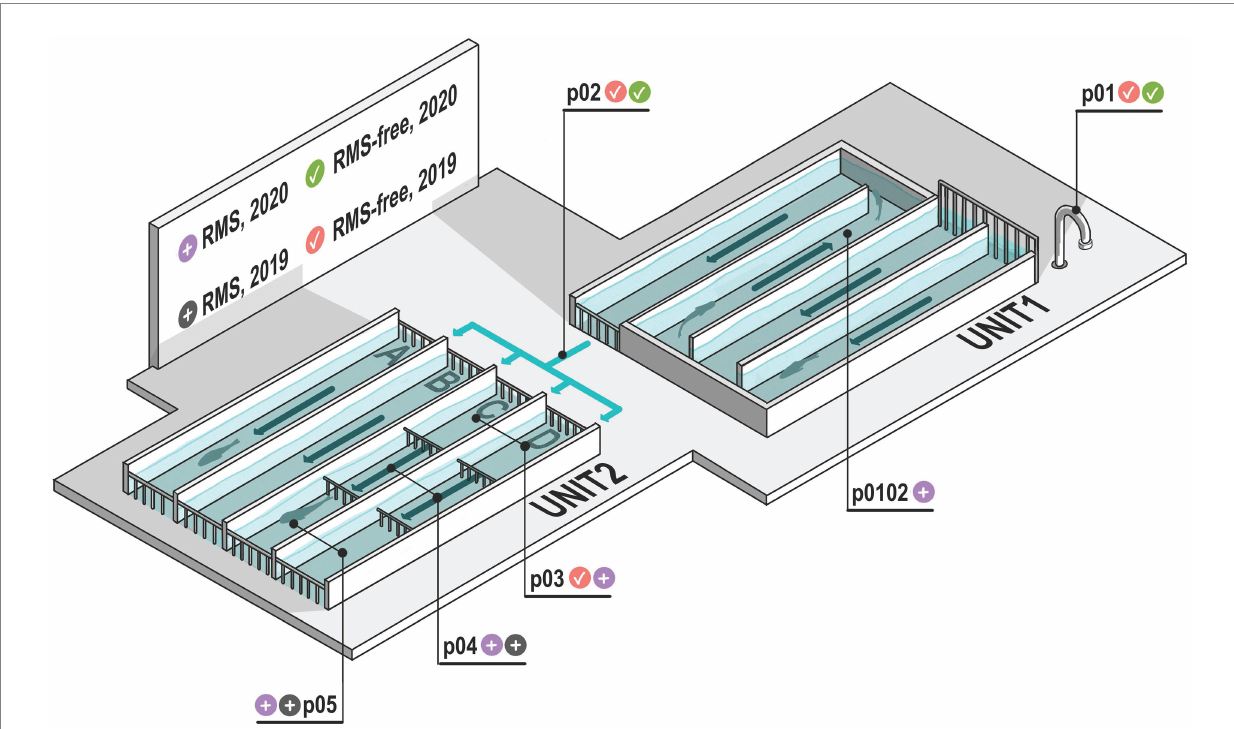
FIGURE 1 Schematic representation of the aquaculture plant examined. Sampling points (p01–p05) are represented. Sampling point p01 is bore well water which feeds the aquaculture system. Sampling point p02 is the water exiting Unit 1 and entering Unit 2. In p01 and p02 there are no fish. Sampling points where RMS was detected are indicated with gray and violet icons, considering the two sampling years (2019 and 2020, respectively). Similarly, sampling points where RMS was not detected (RMS-free) are indicated with red and green icons, considering the two sampling years (2019 and 2020, respectively). Arrows indicate the water